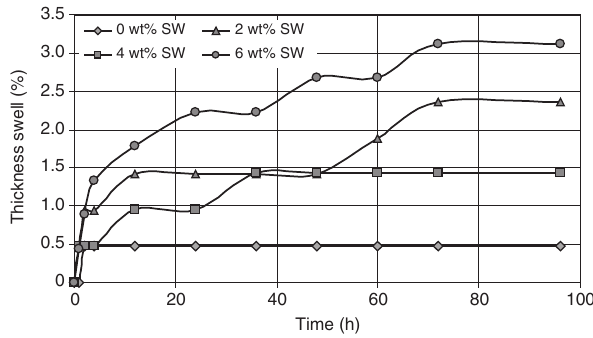
Figure 13 TS as a function of soaking time for different weight percentages of coconut fiber in SW.